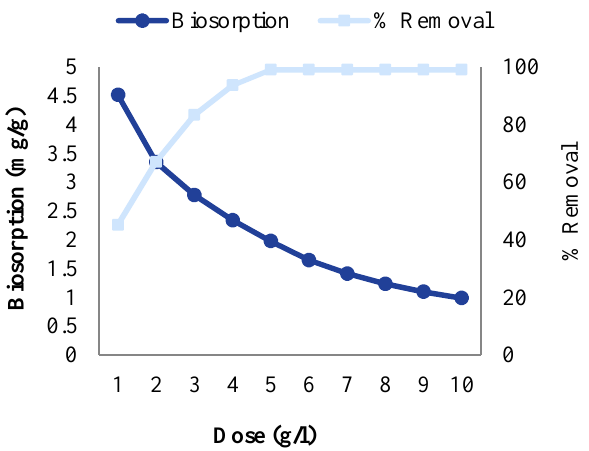
Figure 4. Effect of biomass dose on Cr (VI) biosorption on dried canola (C0 = 10 mg/l, pH = 3, contact time = 75 minutes, and temperature = 30